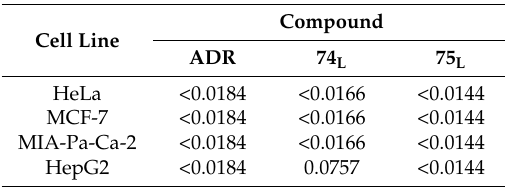
Table 16. Cytotoxicity data of 74 L and 75 L 1 .